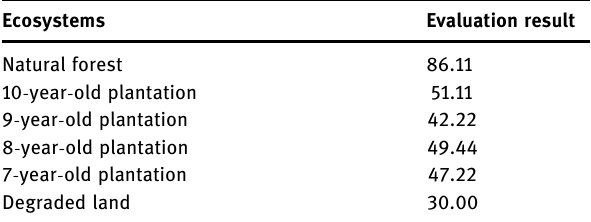
Table 5: Soil health fi eld evaluation